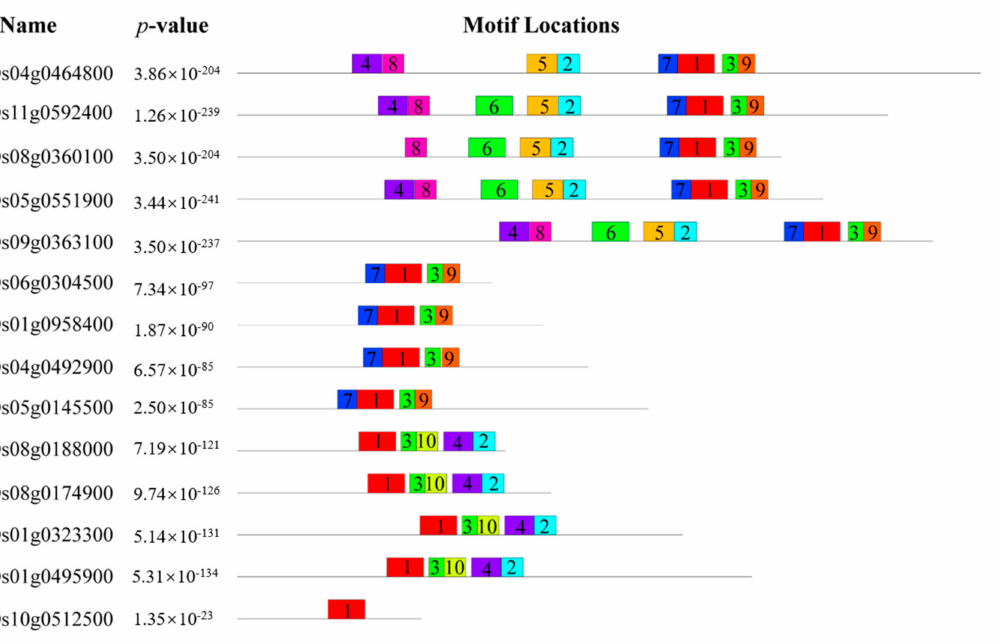
Figure 3. Conserved putative motif analysis of CRM domain proteins in rice. Ten putative motifs are shown in di ff erent colored